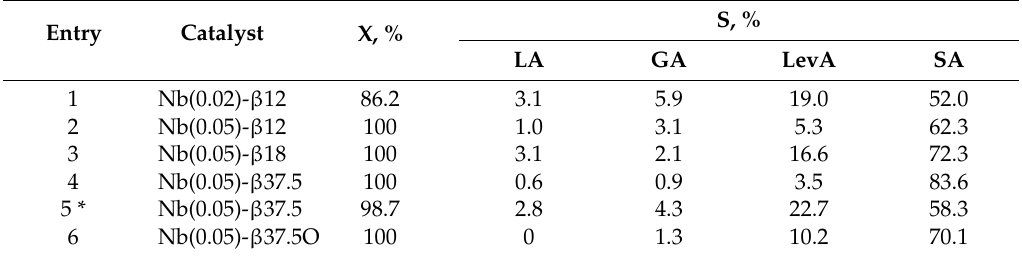
Table 3. Reaction products distribution in catalytic wet oxidation (CWO)